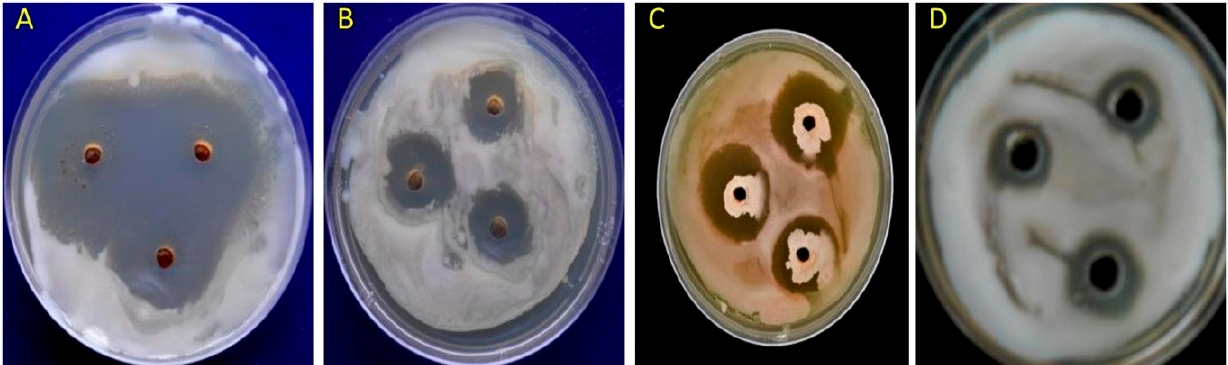
Figure 6. Inhibition zone formed by clone product of polyketide antibiotic synthase genes of Bacillus amyloliquefaciens DSBA-11 against R. pseudosolanacearum. ( A ) B. amyloliquefaciens DSBA-11 (Wild strain) ( B ) clone of difficidin gene ( C ) clone of macrolactin gene ( D ) bacillaene